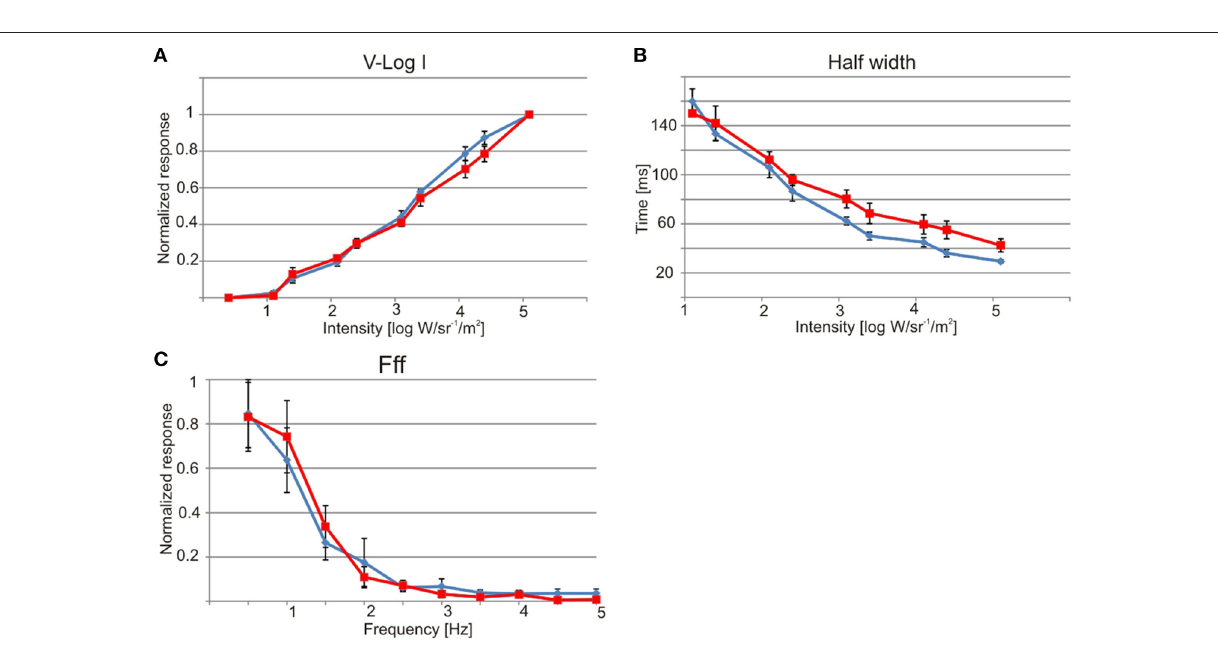
FIGURE 4 | Physiology of the lens eyes. Upper lens eye (ULE) in blue and lower lens eye (LLE) in red. (A) V-log I curve showing a dynamic range of about four log units from ∼ 10 to 1 × 10 5 W/sr/m 2 . (B) The half width of the impulse response decrease with increasing intensity. At max intensity the half width was 29ms for ULE and 42ms for LLE. (C) Both lens eyes are very slow and had flicker fusion frequencies (fff) of about 2.5Hz. All curves are showing mean ± S.E.M. N = 7, except for (C) where N =